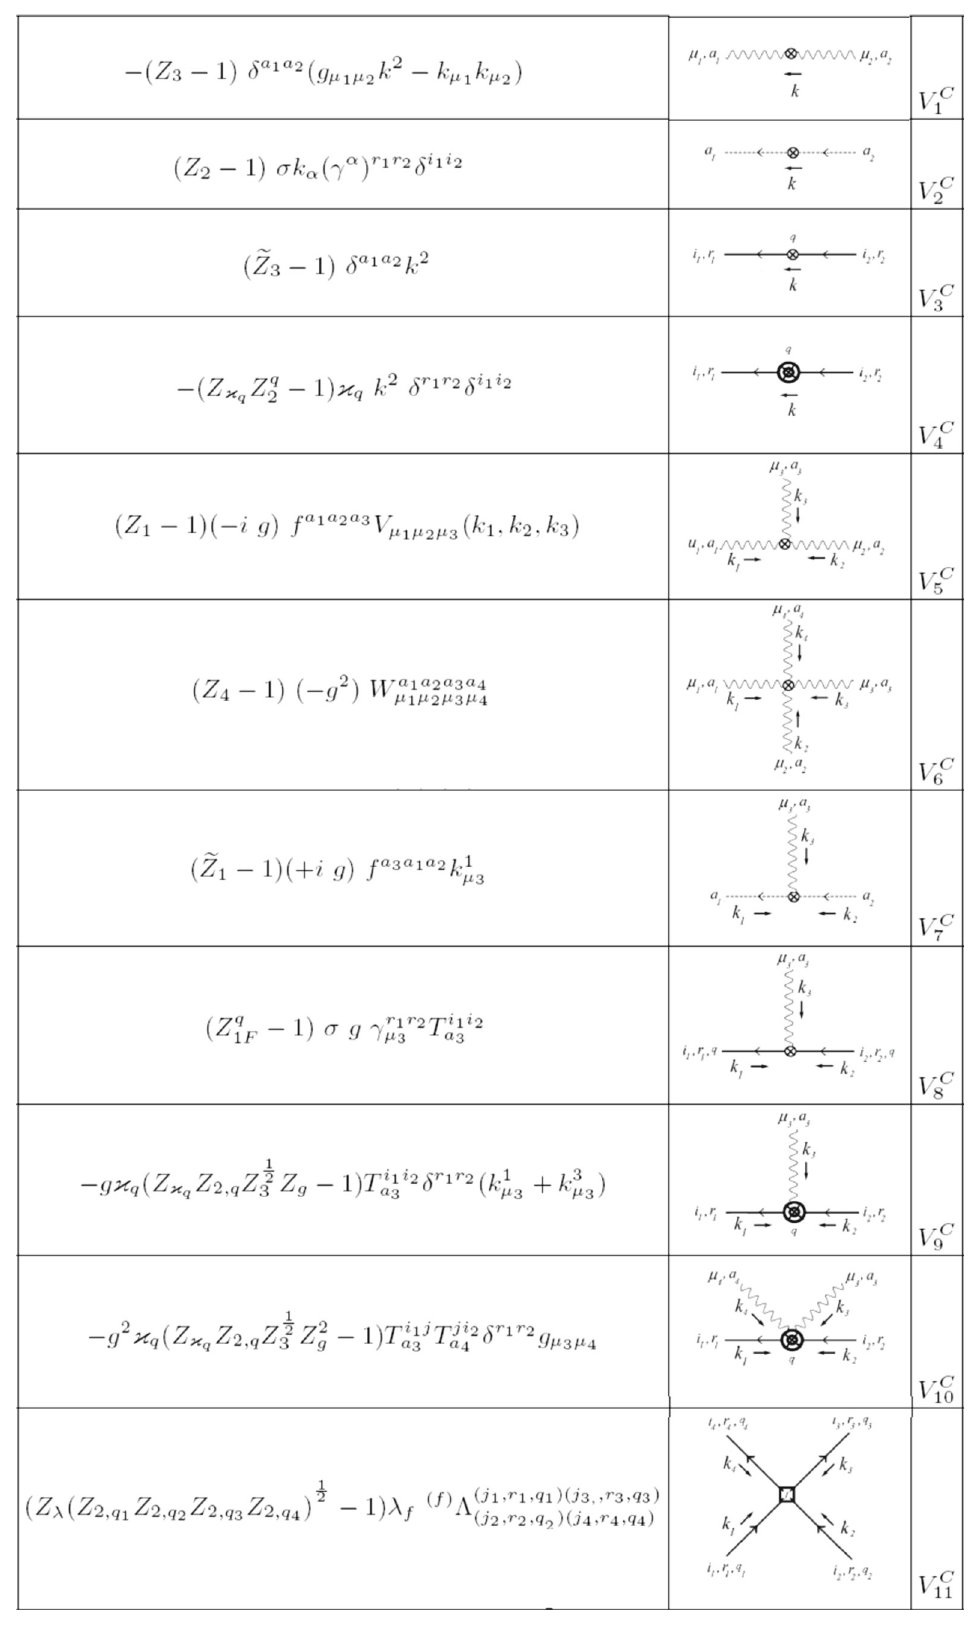
Fig. 5 The eleven counterterm vertices implementing the